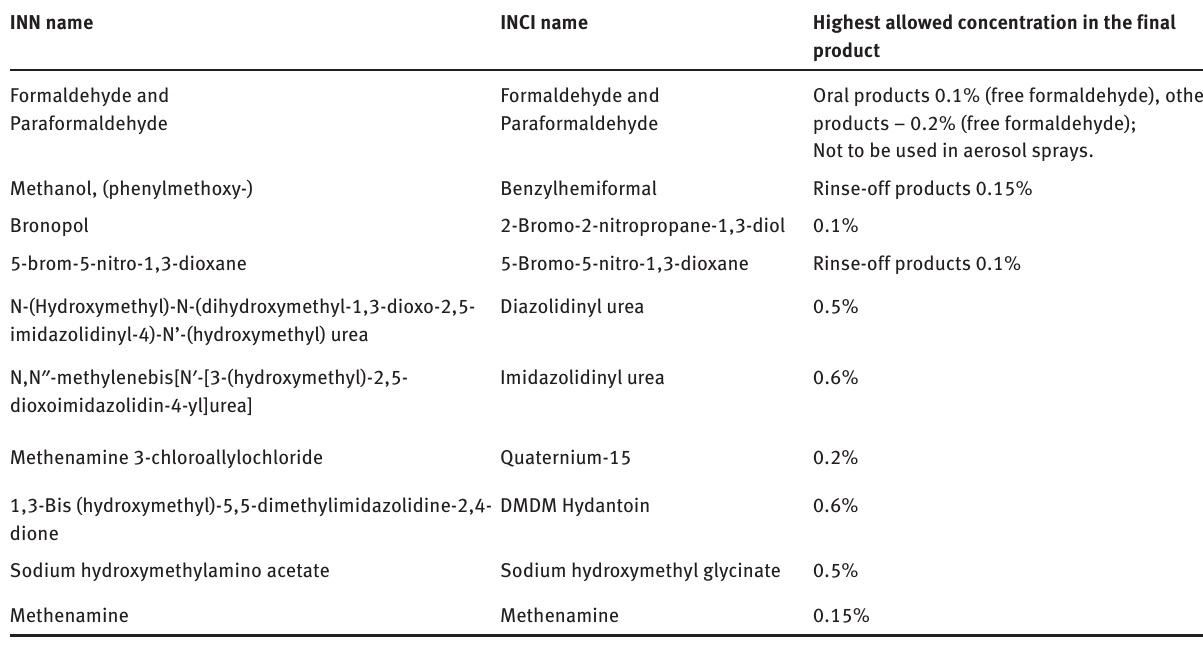
Table 1. List of formaldehyde releasers allowed to be used in cosmetics in the